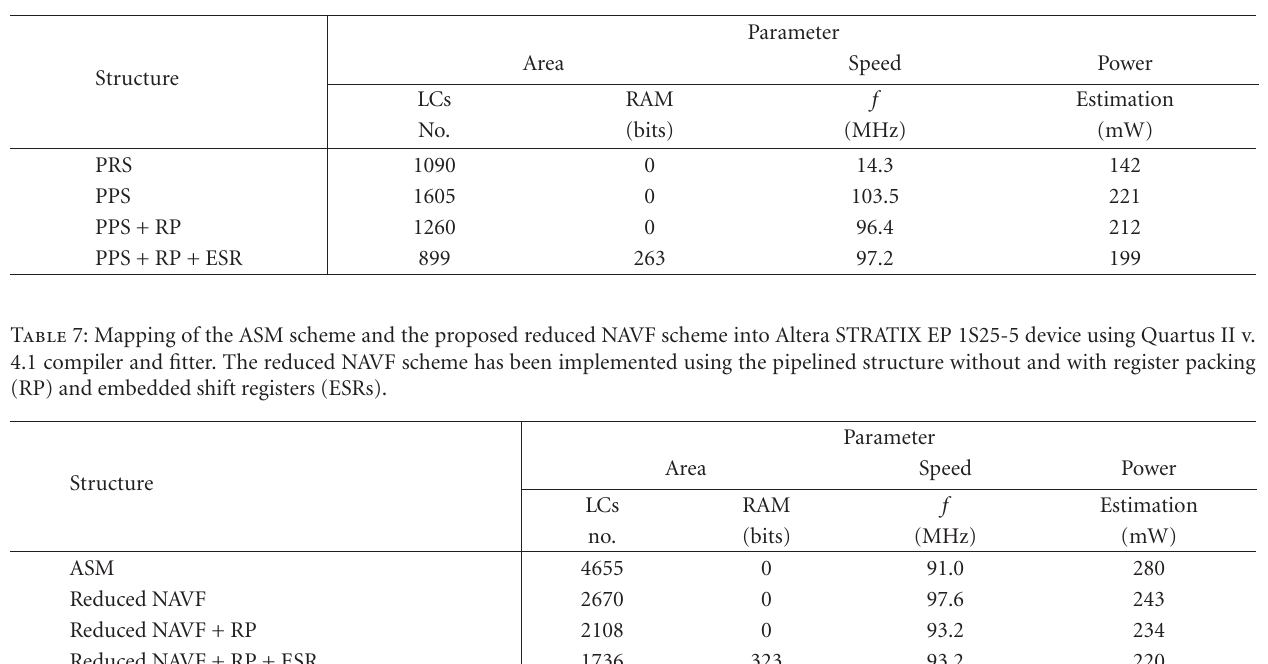
Table 6: Mapping of the LUM smoother for k = 7 and N = 27 into Altera STRATIX EP 1S25-5 device using the Quartus II v. 4.1 compiler and fitter. The filter has been implemented using the parallel structure (PRS), pipelined structure (PPS), PPS with register packing (RP), and embedded shift registers (ESRs).